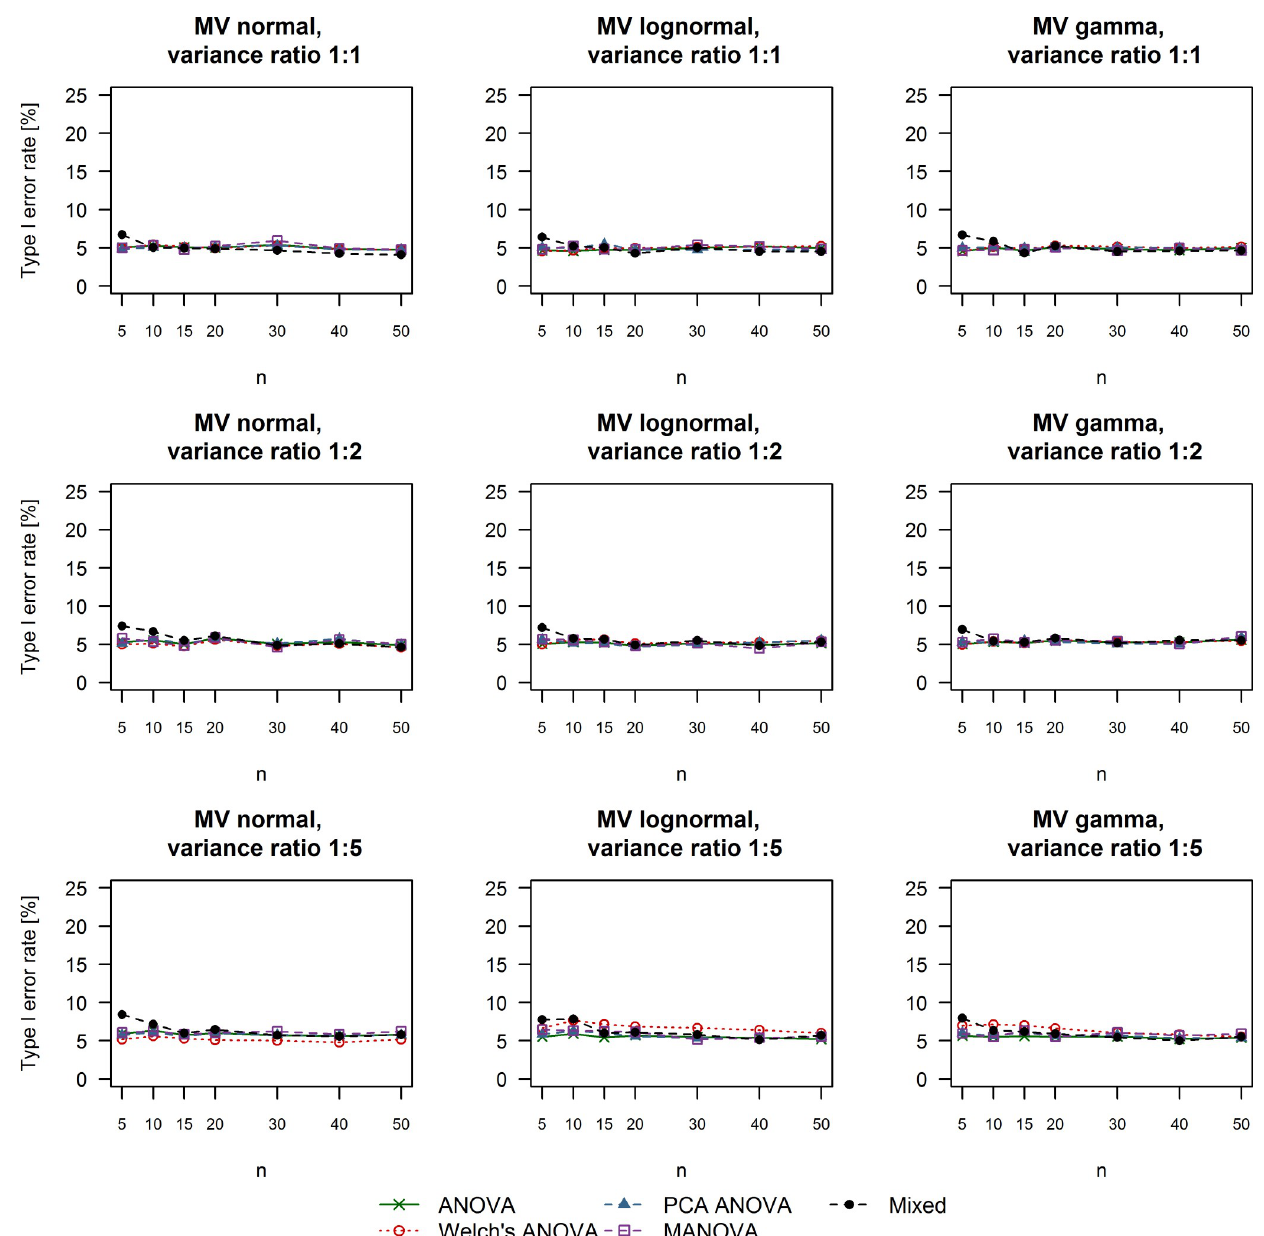
Fig 2. Type I error rate of univariate and multivariate techniques under different simulation conditions. The title of each plot reports the multivariate distribution from which the data were sampled as well as the variance ratio between the simulated control and treatment groups. ANOVA: Analysis of variance; MANOVA: Multivariate analysis of variance; Mixed: Linear mixed effects model; MV: Multivariate; PCA: Principal component analysis. https://doi.org/10.1371/journal.pone.0230798.g002 second multivariate dimensions (indicated by non-overlapping 95% confidence ellipses). LDA captured a false treatment effect pattern in 387 cases corresponding to a false positive rate of 38.7%. In contrast, the control group was not separated from treatment groups in any of the simulated sets when using PCA, PLS-DA, or RDA for dimensionality reduction. Example plots are shown in Fig 6 (the whole set of plots is available in S2 Appendix). Due to the unac- ceptably high false positive rate, we did not further consider LDA. Next, we simulated 1000